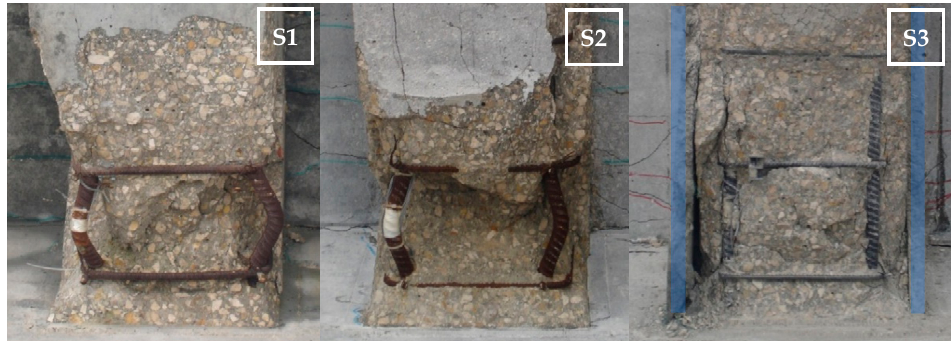
Figure 7. Specimens S1, S2, and S3 failure modes—bottom view of the beam’s critical zone.